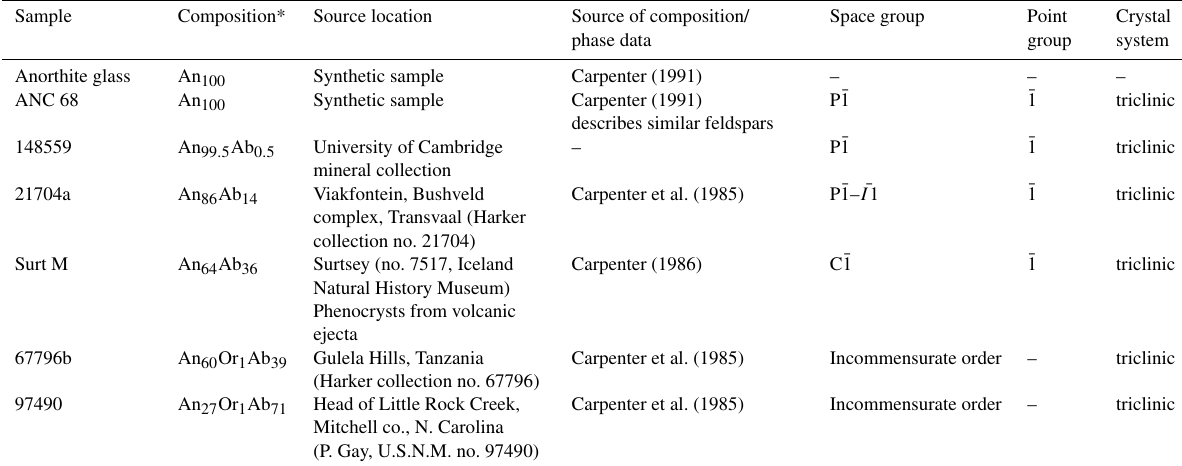
Table 1. Plagioclase feldspars used in this study.